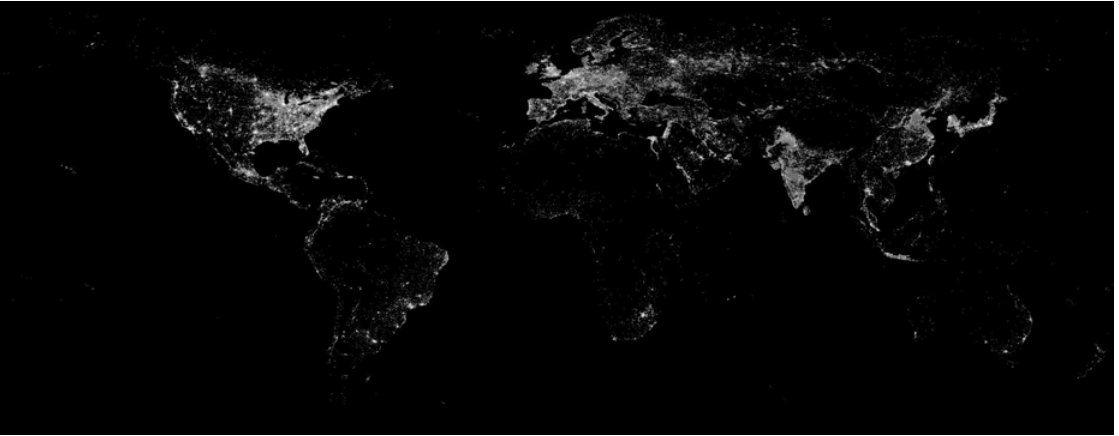
Figure 1. Merged stable lights and radiance-calibrated DMSP-OLS nighttime image of 2000.